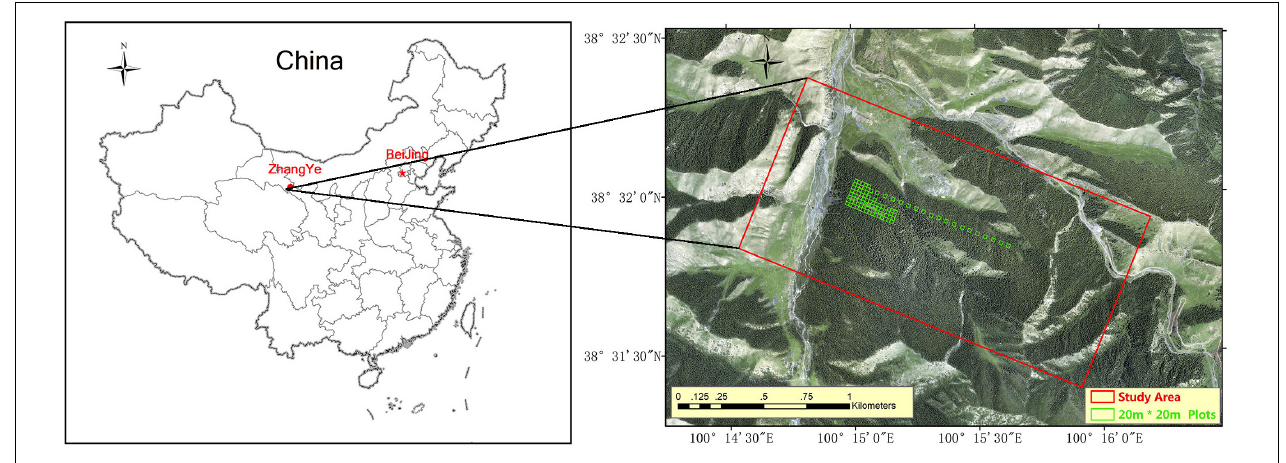
FIGURE 1 | Study area and 94 plots.